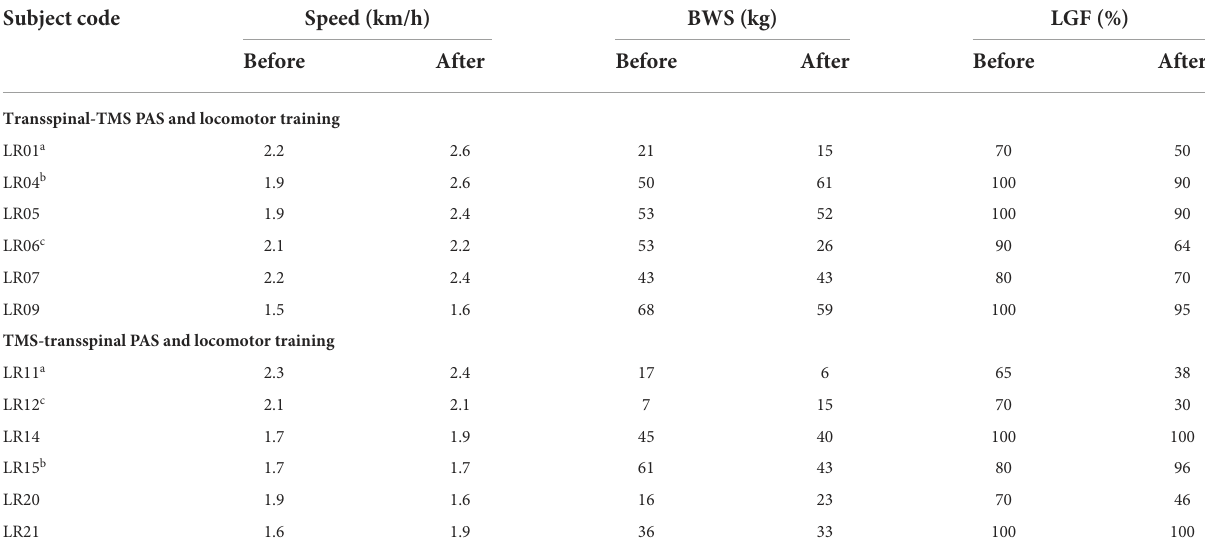
TABLE 2 Training intervention